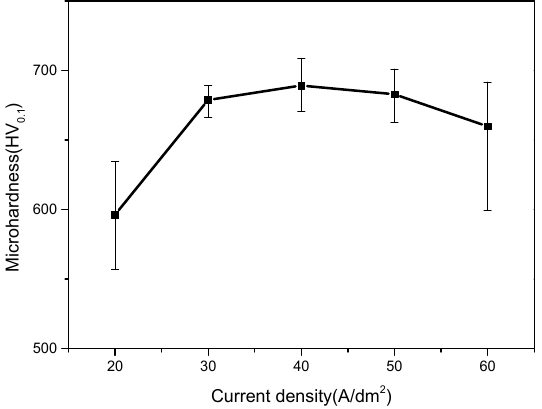
Figure 7. Relationship between microhardness of composite coatings and current density.